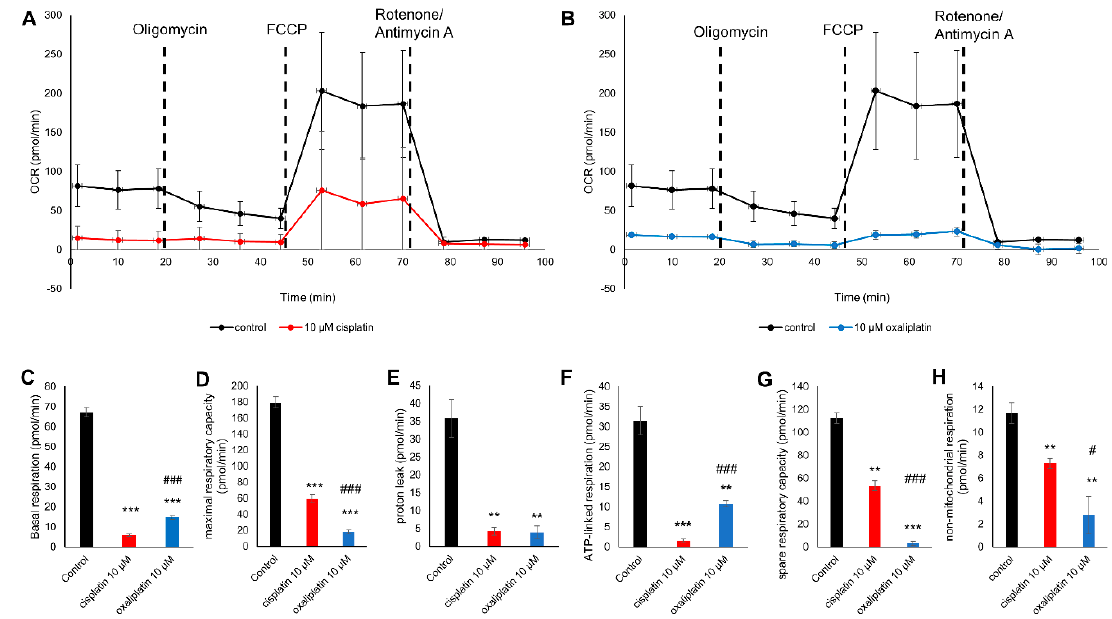
Figure 2. Mitochondrial function after an exposure of 10 µM cis- and oxaliplatin to cultured sensory neurons. ( A ) Oxygen consumption rate (OCR) during the mitochondrial stress assay of sensory neurons exposed to 10 µM cisplatin for 24 h compared to a control. ( B ) OCR during the mitochondrial stress assay of the sensory neurons exposed to 10 µM oxaliplatin for 24 h compared to a control. ( C ) The basal respiration (BR) rate dropped after exposure to cisplatin to 5.856 ± 0.710 pmol / min (*** p < 0.001) and oxaliplatin to 14.682 ± 0.987 pmol / min (*** p < 0.001) compared to the control at 67.095 ± 2.433 pmol / min. Cisplatin-exposed DRG neurons also showed lower BR than oxaliplatin-exposed DRG neurons ( ### p < 0.001). ( D ) The maximal respiratory capacity (MRC) decreased after exposure to cisplatin at 59.252 ± 4.806 pmol / min (*** p < 0.001) and oxaliplatin at 17.857 ± 2.594 (*** p < 0.001) compared to the control cells at 179.528 ± 6.965 pmol / min. The DRG neurons exposed to oxaliplatin showed a lower MRC than cisplatin-exposed DRG neurons ( ### p < 0.001). ( E ) The proton leak (PL) is reduced to 4.241 ± 1.105 pmol / min (** p < 0.01) after exposure to cisplatin and at 3.922 ± 1.748 pmol / min (** p < 0.01) to oxaliplatin compared to 35.776 ± 5.207 pmol / min for the non-treated cells. No di ff erence in the e ff ect of cis- or oxaliplatin exposure could be observed ( p > 0.05) ( F ) The adenosine triphosphate (ATP)-linked respiration (ATPR) was determined at 31.521 ± 3.503 pmol / min at the control and is decreased after exposure to cisplatin at 1.615 ± 0.403 pmol / min (*** p < 0.001) and 10.760 ± 0.763 pmol / min (** p < 0.01) after exposing the cells to oxaliplatin. Cisplatin-exposed DRG neurons show lower ATPR than oxaliplatin-exposed DRG neurons ( ### p < 0.001). ( G ) The spare respiratory capacity (SRC) was decreased after exposure to cisplatin at 53.396 ± 4.138 pmol / min (** p < 0.01) and oxaliplatin at 3.175 ± 1.976 (*** p < 0.001) pmol / min in comparison to 112.433 ± 4.570 pmol / min at the control. Oxaliplatin-exposed DRG neurons had a lower SRC than cisplatin-exposed DRG neurons ( ### p < 0.001). ( H ) The non-mitochondrial respiration (NMR) is decreased after exposure to cisplatin at 7.294 ± 0.432 pmol / min (** p < 0.01) and oxaliplatin at 2.786 ± 1.633 pmol / min (** p < 0.01) compared to 11.672 ± 0.913 pmol / min for the control cells. Oxaliplatin-exposed DRG neurons showed lower NMR than cisplatin-exposed DRG neurons ( # p < 0.05). n = 3 independent experiments per condition. * = significant e ff ect compared to control condition. # = significant e ff ect between cis- and